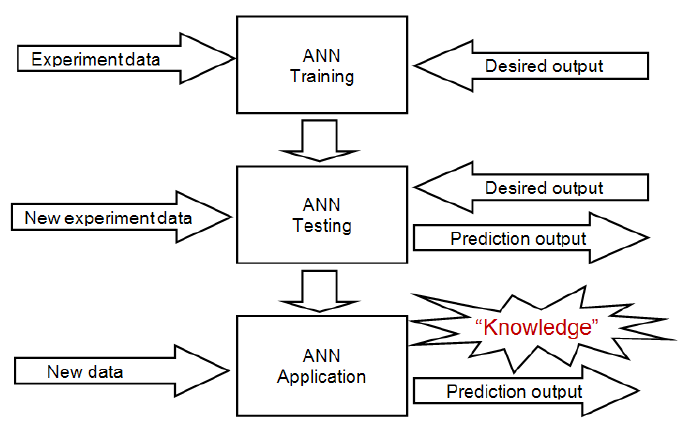
Figure 10. Working principle of